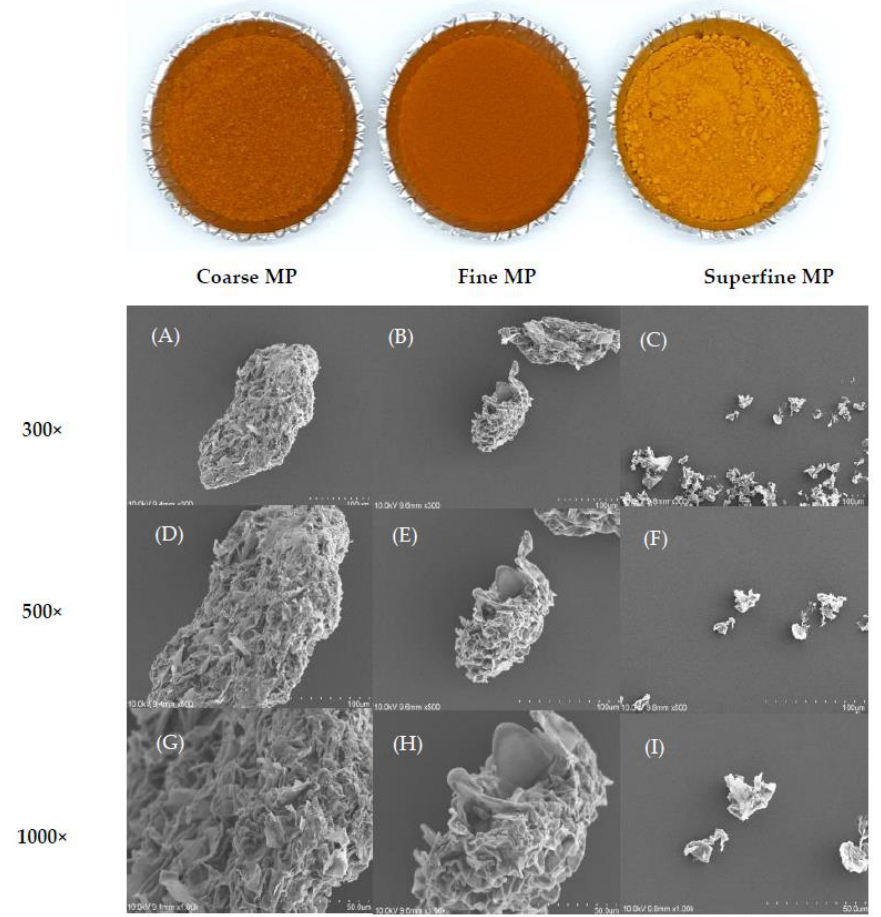
Figure 2. Photographs and SEM images of differently sized MP. Coarse MP: coarse marigold powder. Fine MP: fine marigold powder. Superfine MP: superfine marigold powder. ( A – C ) ×300, ( D – F ) ×500, ( G – I ) ×1000.